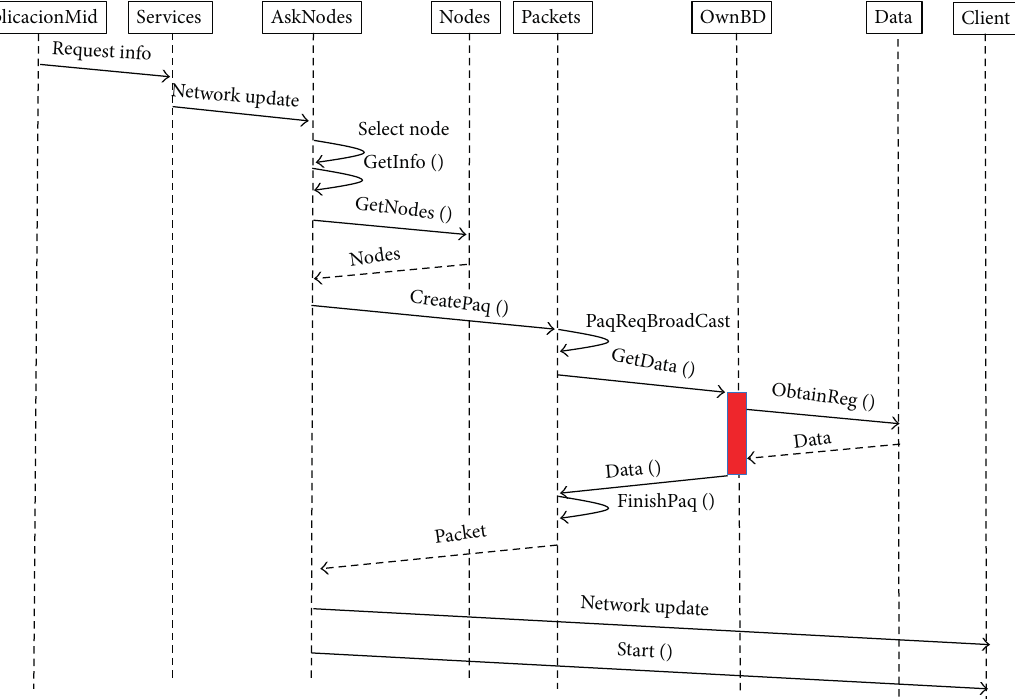
Figure 2: Procedure to request an update from all network